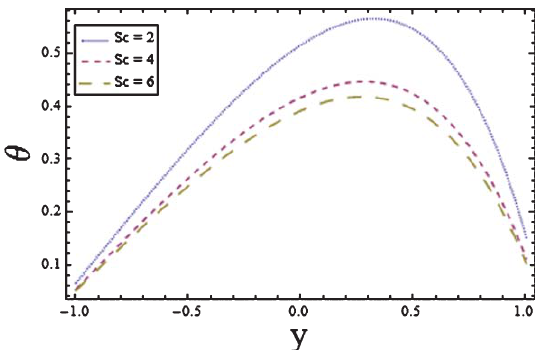
Fig. 9. Plot of the temperature θ for various values of the Schmidt number Sc with (cid:15) = 0 . 2, x = 0 . 1, t = 0 . 1 , Sr = 0 . 8 , Du = 0 . 8 , γ = − 1 . 5 , γ = 10 , Pr = 1 . 5 and γ = 8. 1 2